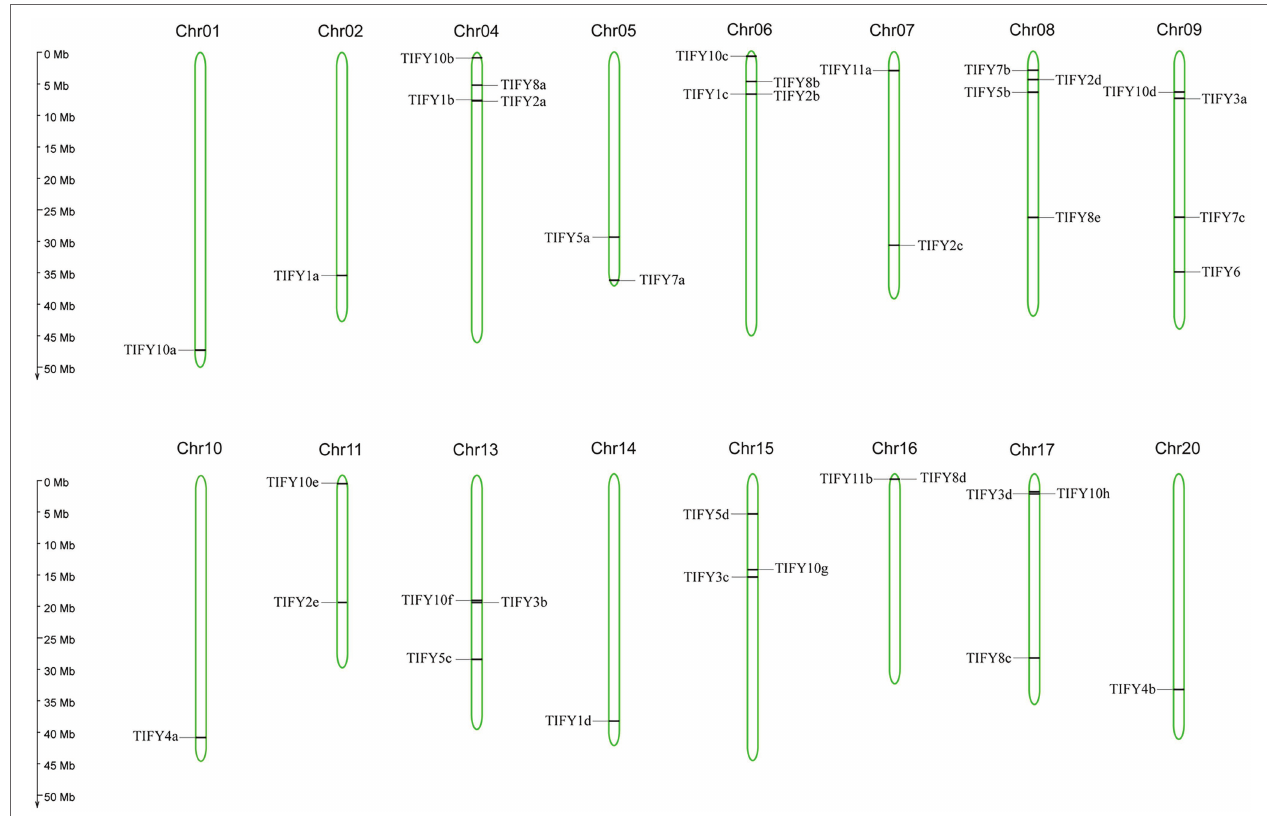
FIGURE 2 | The location of 38 GmTIFY genes on the soybean chromosome. The scale bar on the left indicates the size of the